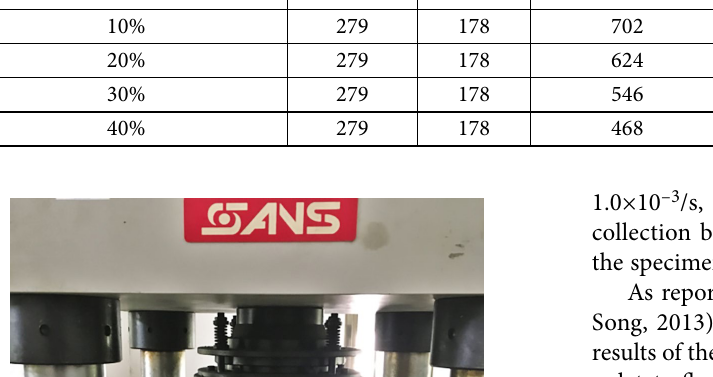
Table 1. Mix proportions of rubber concrete with different substitution rates (unit: kg/m 3 ) Rubber substitution rate